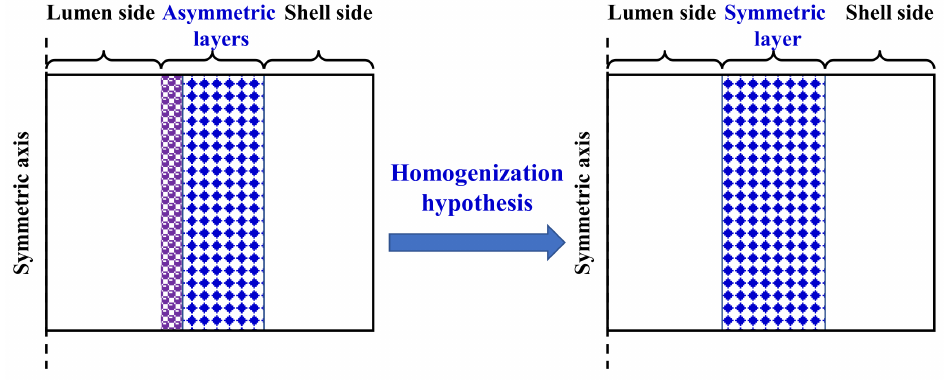
Figure 5. Schematic diagram of a quasi-homogeneous